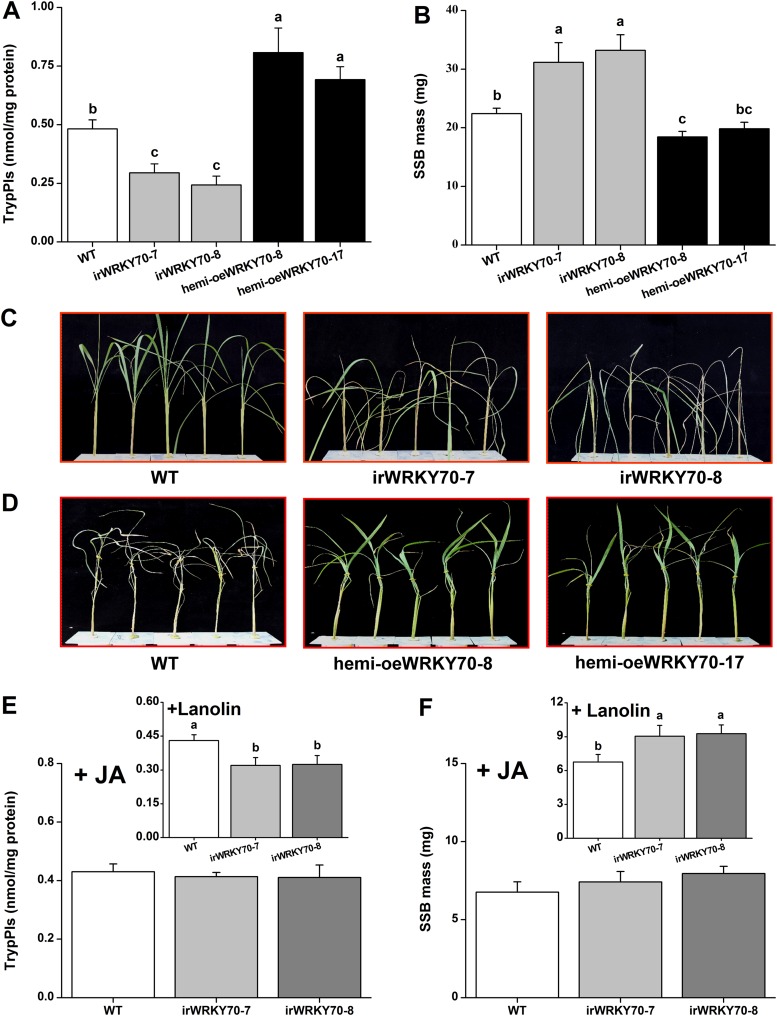
OsWRKY70 positively regulates resistance in rice to SSB.(A) Mean Trypsin protease inhibitor (TrypPI) activities (+SE, n = 6) in irWRKY70, hemi-oeWRKY70, and WT plants that were individually infested by a third-instar SSB larva for 3 days. (B) Mean larval mass (+SE, n = 50) of SSB that fed on irWRKY70, hemi-oeWRKY70, and WT plants for 14 days. (C, D) Damaged phenotypes of irWRKY70 (C), hemi-oeWRKY70 (D), and WT plants that were individually infested by a third-instar SSB larva for 8 days (n = 10). This experiment was repeated twice with similar results. (E) Mean activities (+SE, n = 6) of TrypPIs in irWRKY70 and WT plants that were individually treated either 100 μg JA in 20 μl of lanolin paste (JA) or with 20 μl of pure lanolin (insert) for 24 hr, followed by SSB feeding for 3 days; (F) Mean larval mass (+SE, n = 50) of SSB 12 days after fed on irWRKY70 and WT plants that were individually treated either 100 μg JA in 20 μl of lanolin paste (JA) or with 20 μl of pure lanolin (insert) for 24 hr. Letters indicate significant differences among different lines (p < 0.05, Duncan's multiple range test).